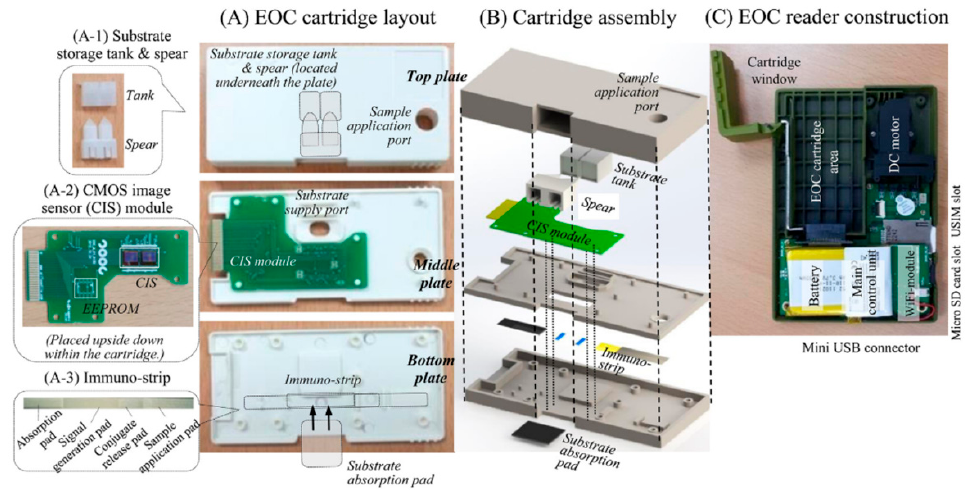
Figure 5. Cartridge layout of an EOC and its assembly, and the EOC reader construction proposed in [49] .